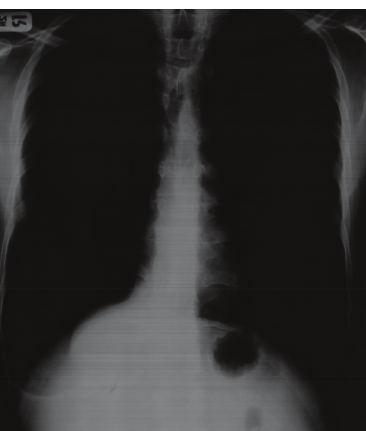
Figure 1: 32-year-old man, diagnosed for ectopic kidney; chest X-ray demonstrated hyperinflation of both lungs, with round soft tissue density in the cardiophrenic angle, which does not silhouette the cardiac shadow.